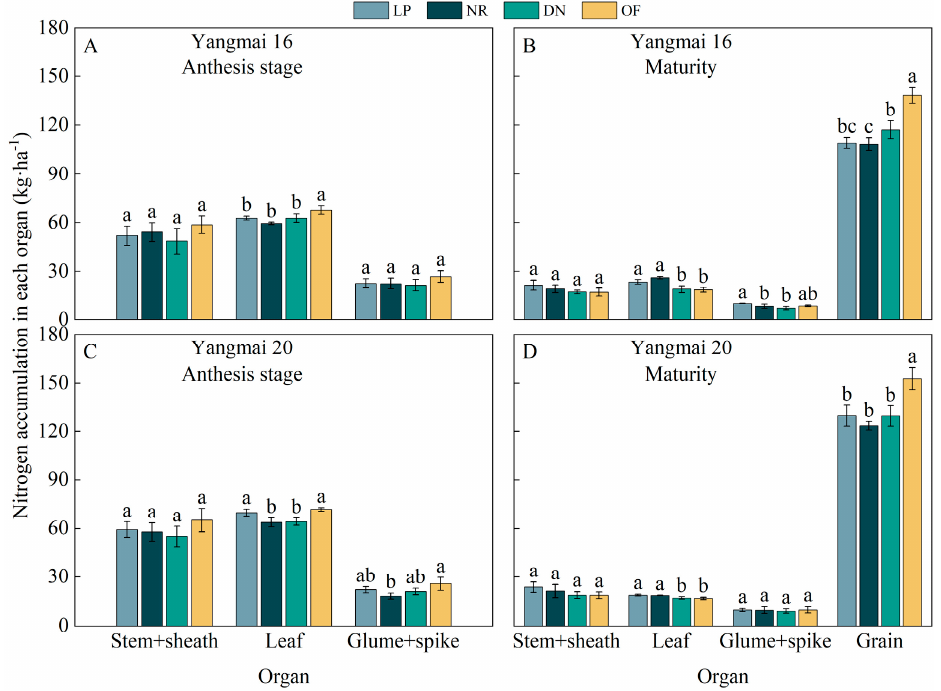
Figure A2. Effect of integrated cultivation practices on nitrogen accumulation in each organ of two wheat cultivars Yangmai 16 ( A , B ) and Yangmai 20 ( C , D ) in 2020–2021. LP, NR, DN, and OF indicate local practices, nitrogen reduction, planting density reduction and nitrogen reduction, and organic fertilizer, respectively. The vertical bar represents the ± standard error of the mean. Different lowercase letters indicate the same organ; the difference between different treatments was significant at the 0.05 level.